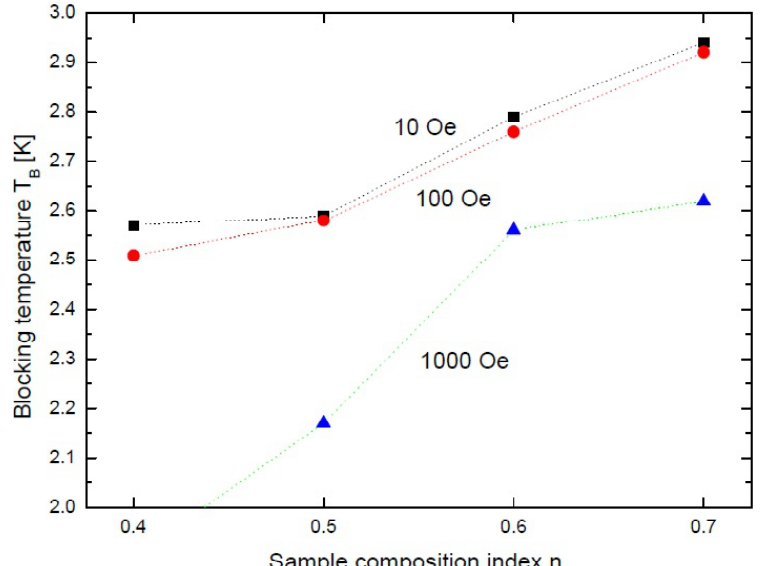
Fig. 7. Dependence of the blocking temperature T on external magnetic field H ( H = 10, 100, 1000 Oe) in B four samples ( n = 0.40, 0.50, 0.60, 0.70) synthesised under pressure 3.8 MPa. Blocking temperature for sample n = 0.30 in H = 1000 Oe is below 2K and could not be measured on our magnetometer.